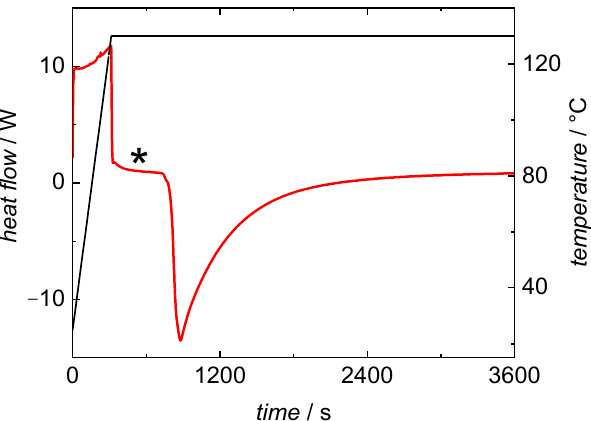
Figure 1. DSC curve from a BA polymerization at 130 ◦ C under isothermal conditions. The heat flow curve (red) and temperature profile (black) were recorded while heating to the desired temperature and during the bulk polymerization. * marks the baseline used for data evaluation.